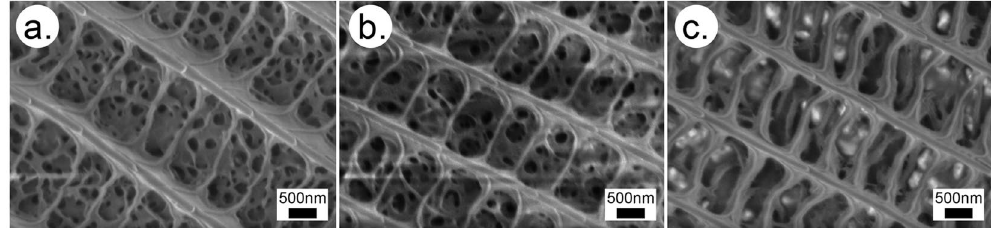
Figure 7. SEM images of the wing scales of the female eclosed from a pupa cooled for 20 days. ( a ) Dentate apex blue scale, ( b ) rounded apex blue scale, ( c ) brown